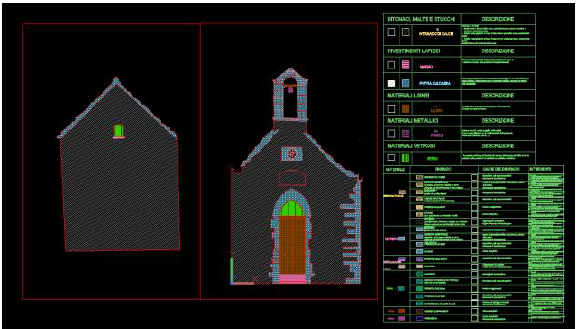
Figure 6. Thematic table on materials analysis